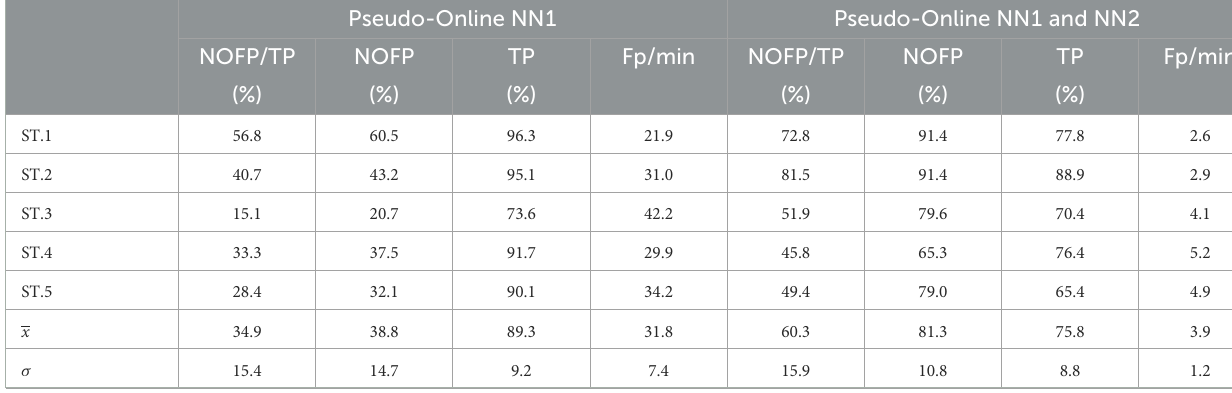
TABLE 5 Comparison of the performance of the BMI for treadmill experiments using NN1 model vs. NN1 + NN2 model. Pseudo-Online NN1